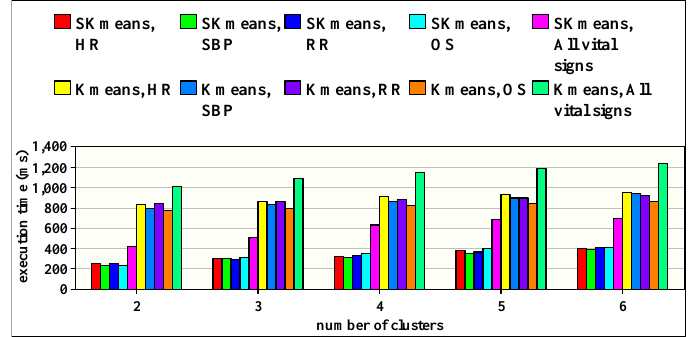
Figure 8. Execution time when applying SKmeans and